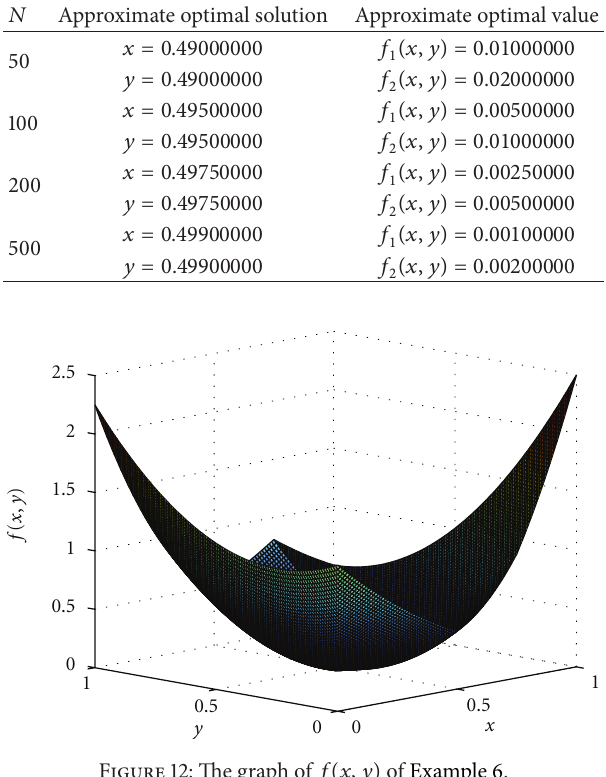
Table 3: Numerical results of Example 6.